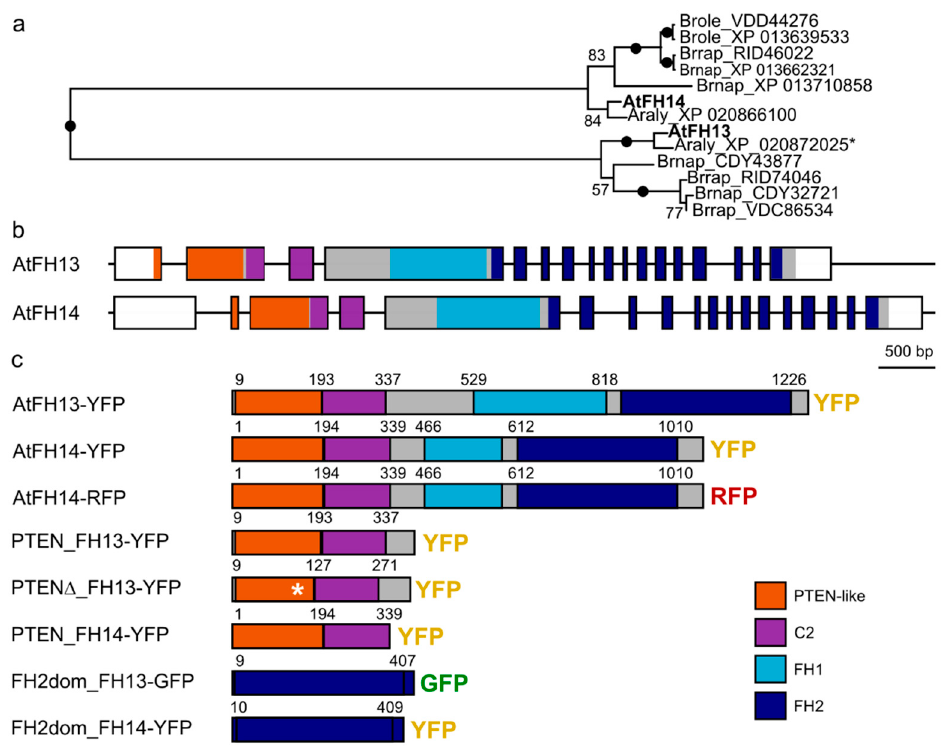
Figure 1. Evolutionary relationships of Arabidopsis Class II formins (AtFH13 and AtFH14), structure of the AtFH13 and AtFH14 genes, and constructs generated in this study. ( a ) Maximum likelihood phylogenetic tree of joined PTEN, C2 and FH2 domains of AtFH13, AtFH14 and their homologs from Arabidopsis lyrata (Araly), Brassica napus (Brnap), B. rapa (Brrap), and B. oleracea (Brole). Sequences are identified by their GenBank accession numbers; the asterisk marks a predicted protein sequence modified to include missing conserved exons (see Methods). Numbers denote bootstrap support (out of 100 replicates), branches with 100% support are marked by dots. ( b ) Exon–intron structure of both genes with non-coding (UTR) parts of exons represented by white boxes and coding exons shown either in grey or in color (for known domains). ( c ) Schematic representation of tagged protein constructs used in this study. Asterisk indicates the position of the 21 amino acids deletion in the mutant PTEN ∆ domain, starting from position 106 of the standard AtFH13 sequence. The numbers indicate amino acid positions related to the N-end. Domain abbreviations are defined in the text.